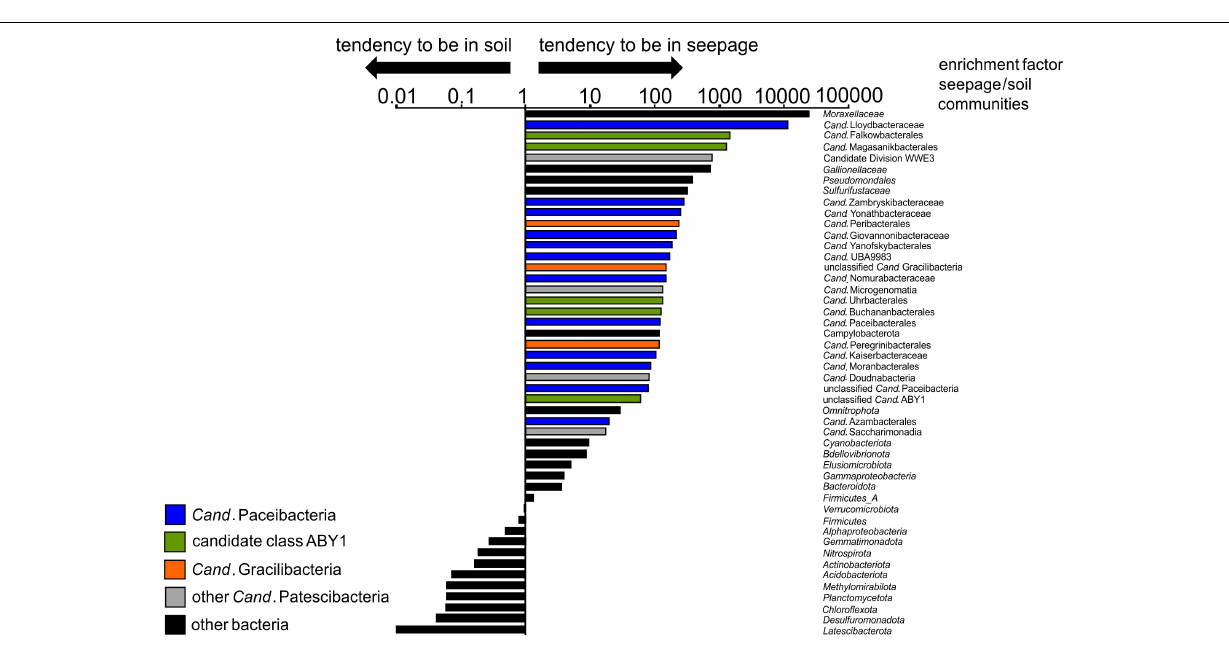
FIGURE 5 | Enrichment factors in seepage compared to soil for selected bacterial taxa (order/family level for Cand . Patescibacteria, class level for Proteobacteria , phylum level for other Bacteria). For calculation of these factors, mean values of relative abundances of a given taxon across all seepage samples from four locations and different time points ( n = 10) were divided by mean values of relative abundances of the same taxon across all forest soil samples ( n = 10). Relative abundances of taxa are based on 16S rRNA gene-targeted Illumina MiSeq amplicon sequencing.